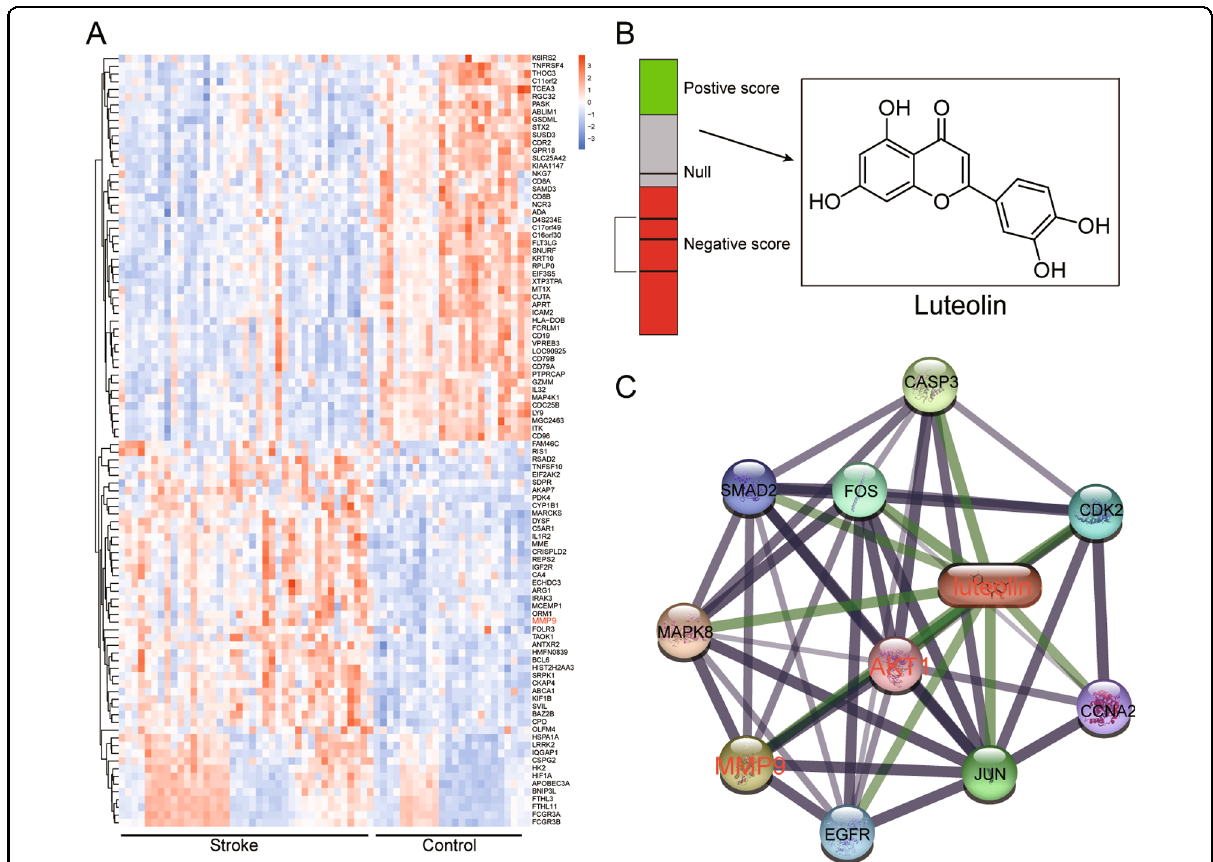
Fig. 1 Luteolin is a potential treatment option for ischemic stroke. a Differentially expressed mRNAs were analyzed by microarray and presented on a heatmap. b Bar graph represents the connectivity score data for luteolin. The black horizontal lines represent each instance performed with the respective compound. Instances in the red area indicate negative correlation scores, and instances in the green area indicate positive ones. No correlation could be detected for instances in the gray area. The chemical structure of luteolin is also shown. c The target proteins of luteolin, MMP9 , and AKT1 were identi fi ed using